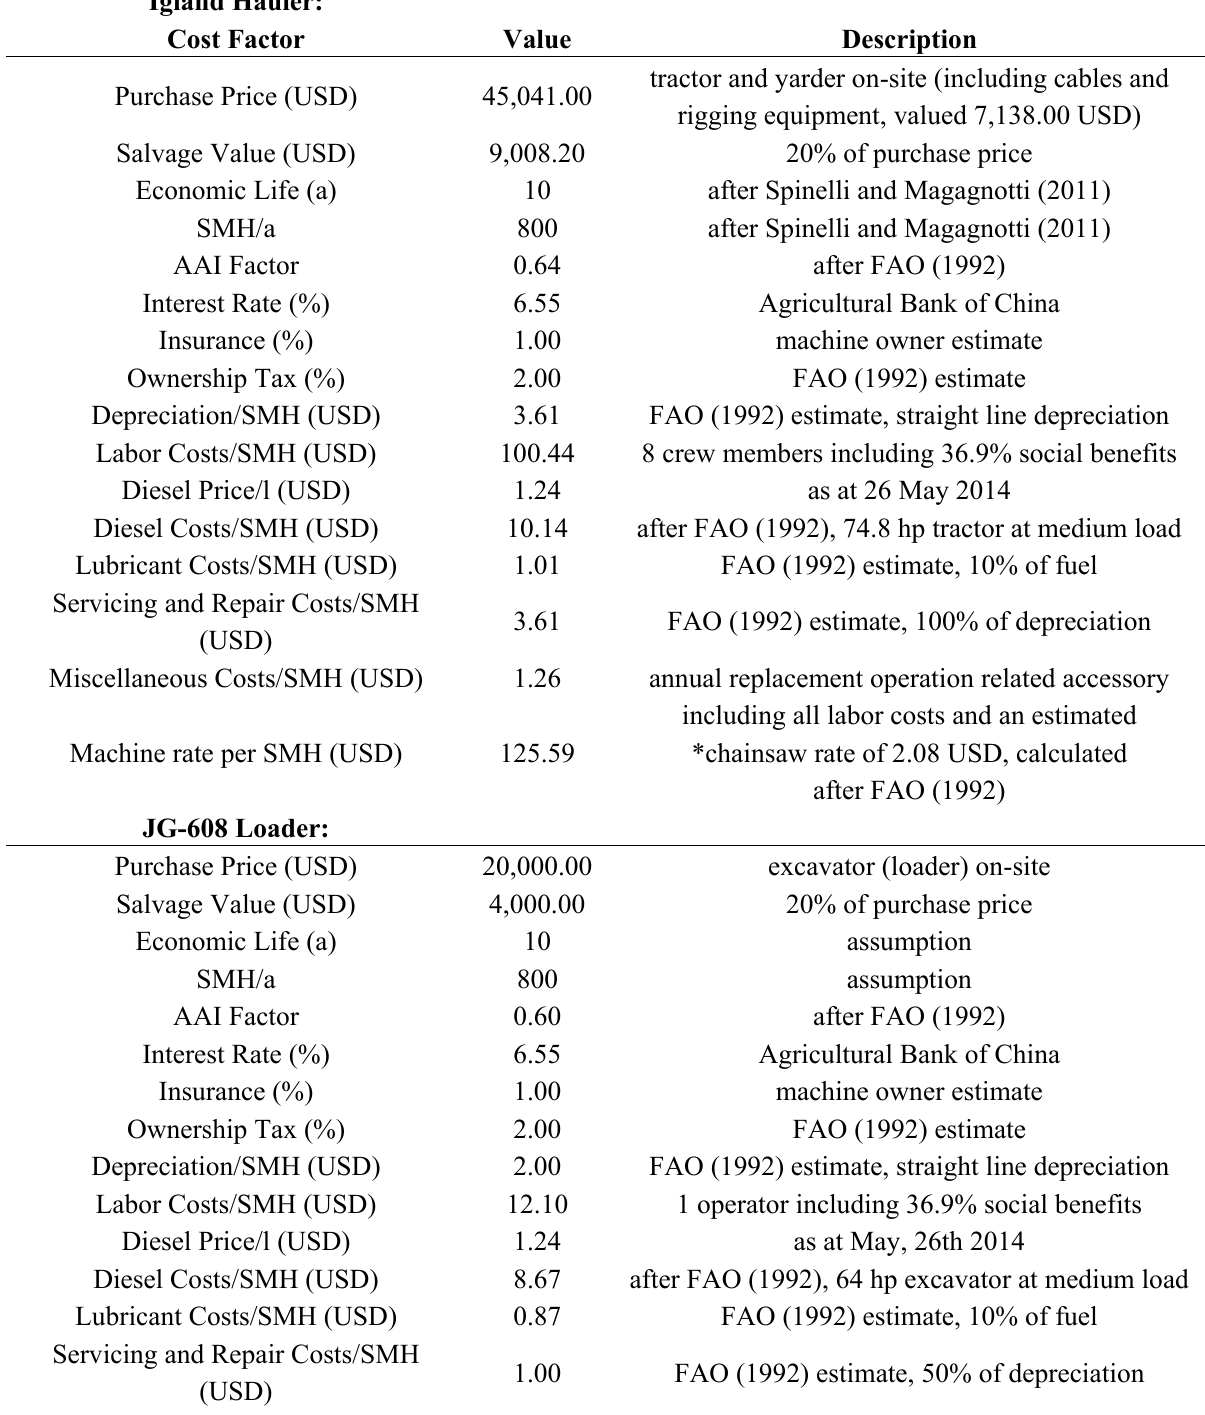
Table 5. Machine costing for the Igland Hauler and the JG-608 loader added for alternative cost